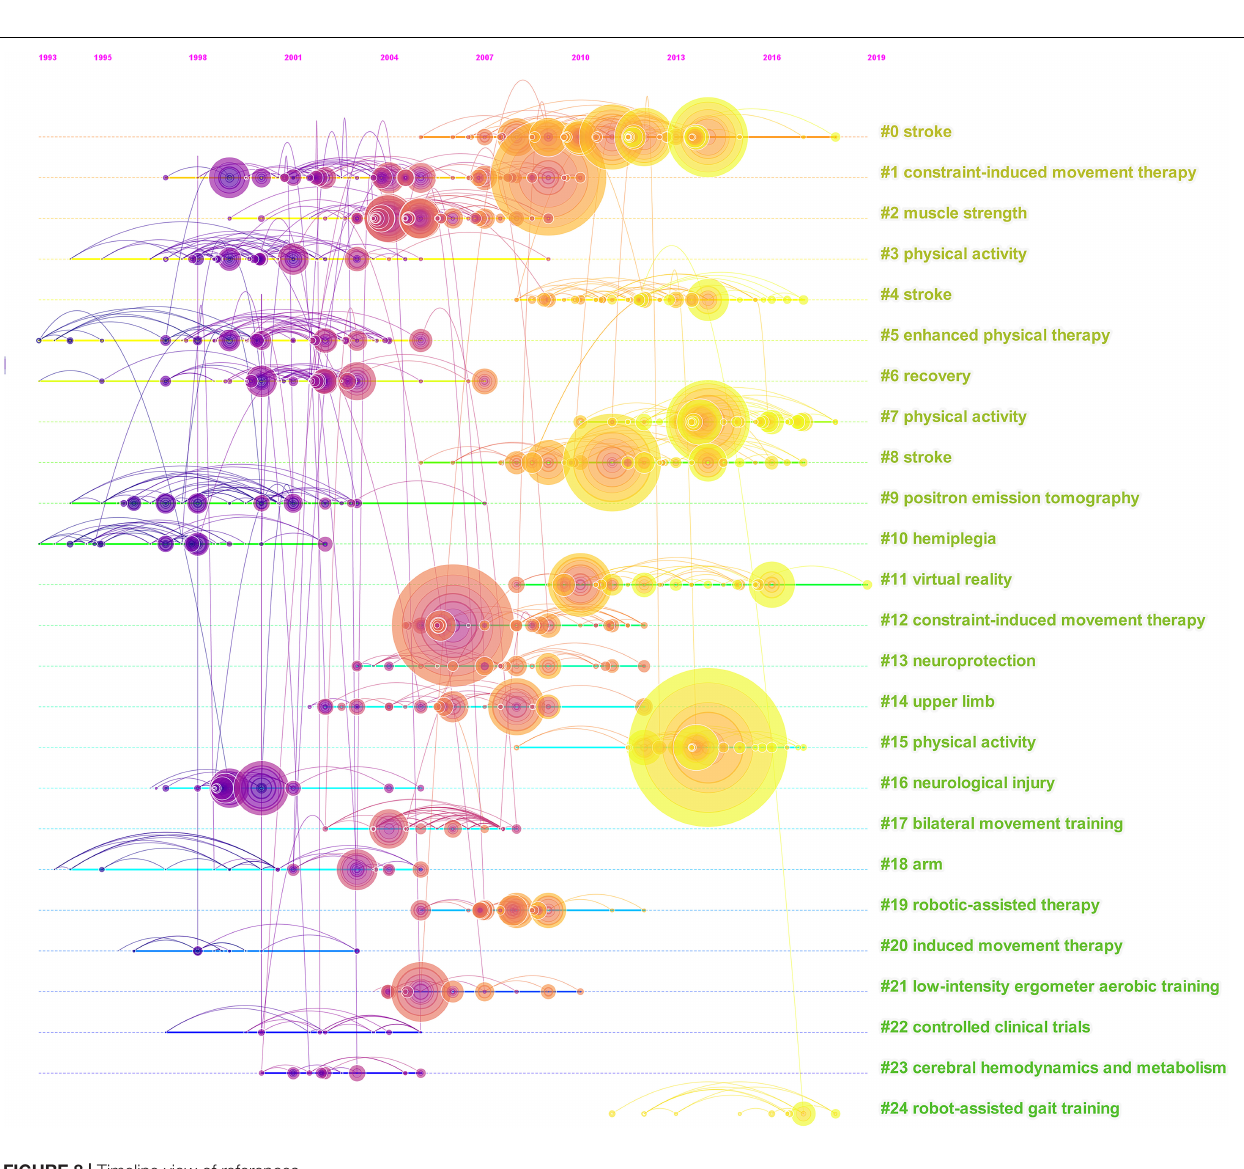
FIGURE 8 | Timeline view of